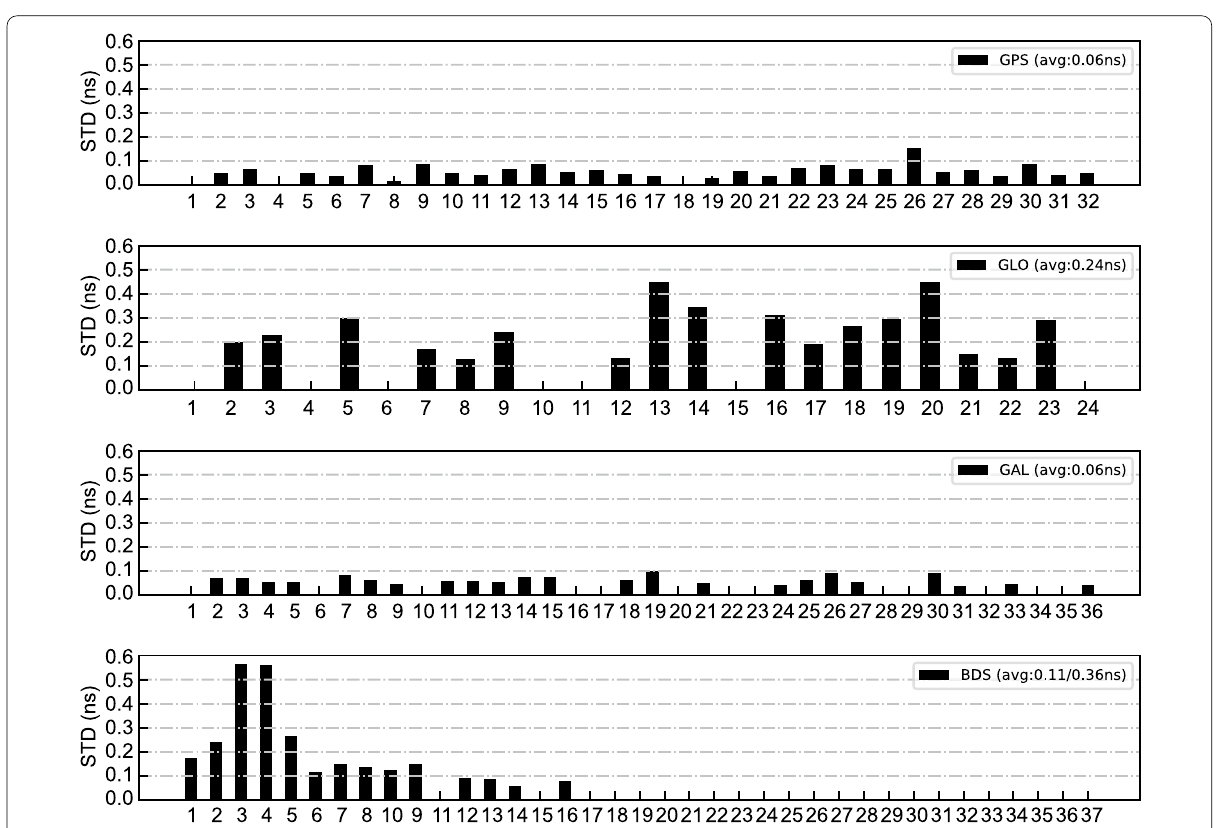
Fig. 5 STD of the satellite clock differences between the operational real-time estimates and the GBM final products, for GPS, GLONASS, GALILEO, and BDS from top to bottom. The average values of all satellites for each system are given in the legend. Note that for BDS the average values of the IGSO/MEO and GEO satellites are both